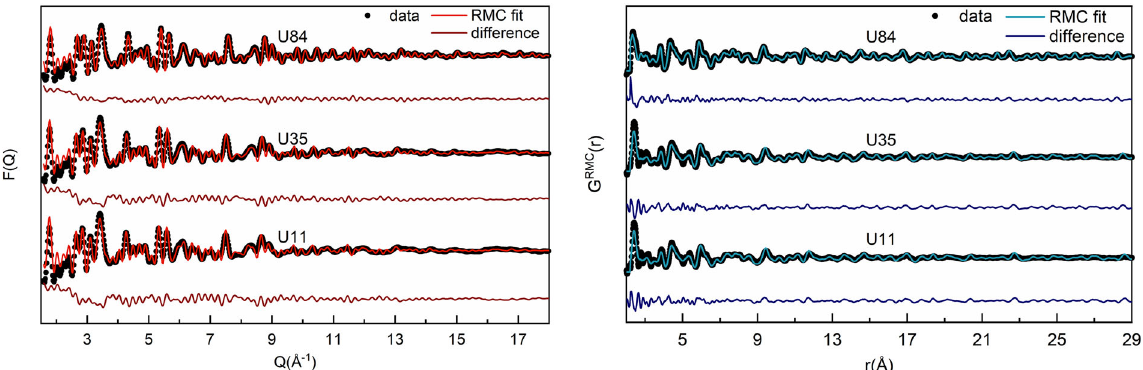
Fig. 3 RMC modeled curves for uranothorites. Measured F ( Q ) and G RMC ( r ) data are provided in black and fi tted F ( Q ) and G RMC ( r ) curves are overlaid in red and cyan, respectively. The differences between the measured data and the RMC models are provided underneath the overlaid plots.